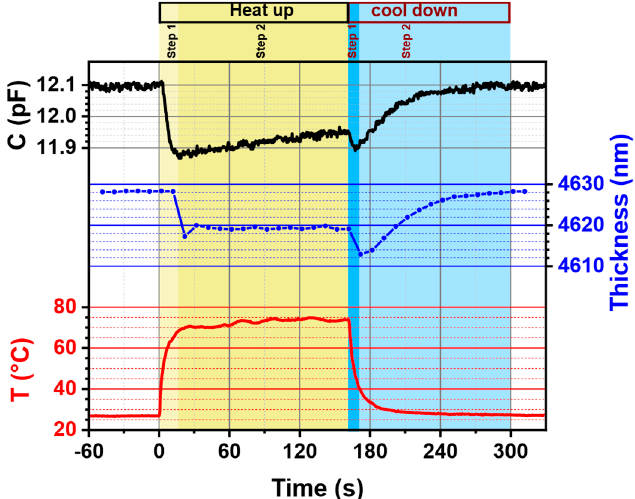
Figure 1. Change of the capacitance and the sensing polyimide layer thickness dependent time after applying a thermal perturbation to the sensor. The thermal perturbation is done by heating up and cooling down the sensor between 27 and 74 °C for a constant RH =